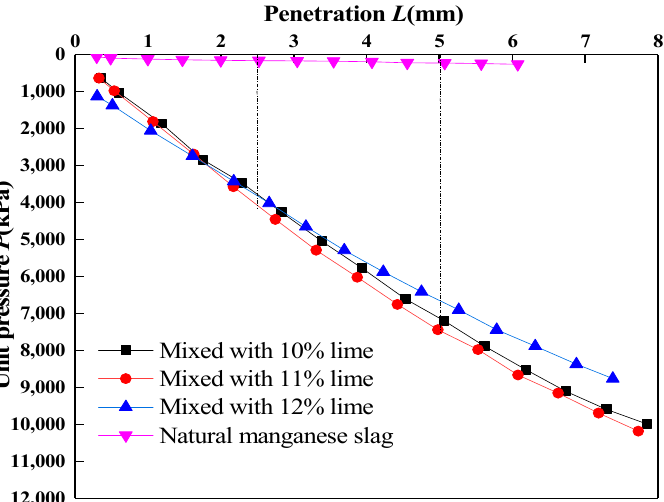
Figure 8. The relationship curve between unit pressure and penetration of lime-solidified manganese slag.